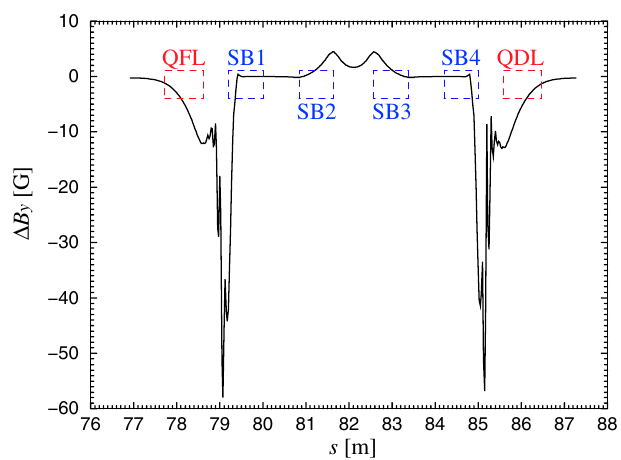
FIG. 4. (Color) Magnetic field difference between the two meth- ods of field calculations at x (cid:4) y (cid:4) 0 . The whole-system calcu- lation result was subtracted from the sum of the individual calculations of an isolated